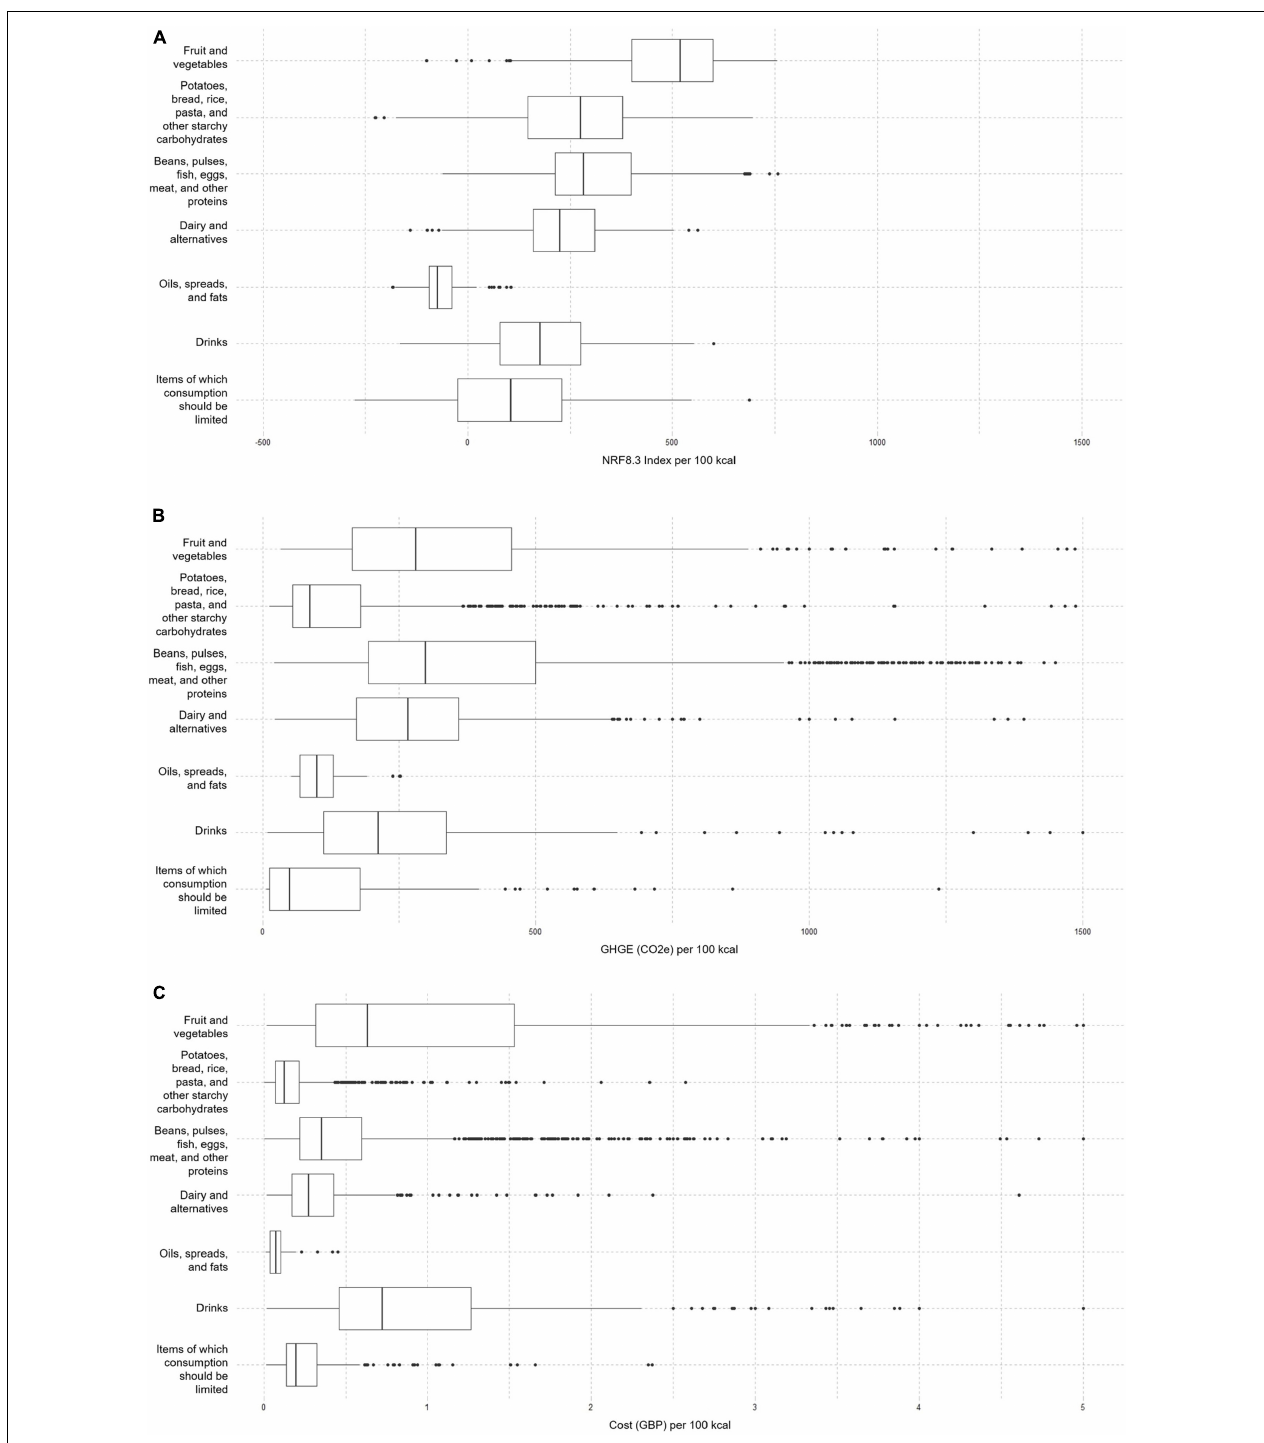
FIGURE 1 | (A) The overall NRF 8.3 median across all the food and beverage items included in the analysis was 287/100 kcal. The medians per food categories were as follows: fruit and vegetables 507/100 kcal; potatoes, bread, rice, pasta, and other starchy carbohydrates 275/100 kcal; beans, pulses, fish, eggs, meat, and other proteins 283/100 kcal; dairy and alternatives and 225/100 kcal; oils and spreads and animal fats -72/100 kcal; Drinks 184/100 kcal; and foods high in fat, salt, or sugar 124/100 kcal. (B) The overall GHGE median across all the food and beverage items included in the analysis was 211/100 kcal. The medians per food categories were as follows: fruit and vegetables 281/100 kcal; potatoes, bread, rice, pasta, and other starchy carbohydrates 87/100 kcal;